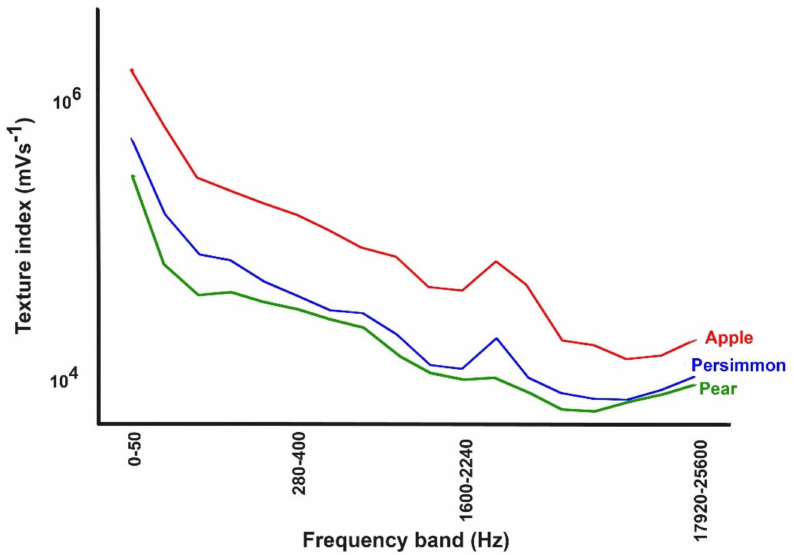
Figure 9. Calculated texture indices for apples, persimmons and pears with texture index versus frequency (modified from [92]).